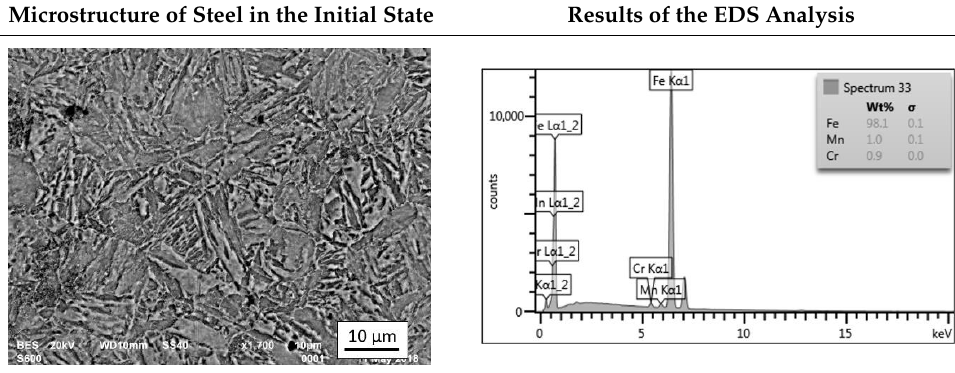
Table 5. Microstructure of steel after heating at 600 °C for 60 min and 240 min with air-cooling and water-cooling.